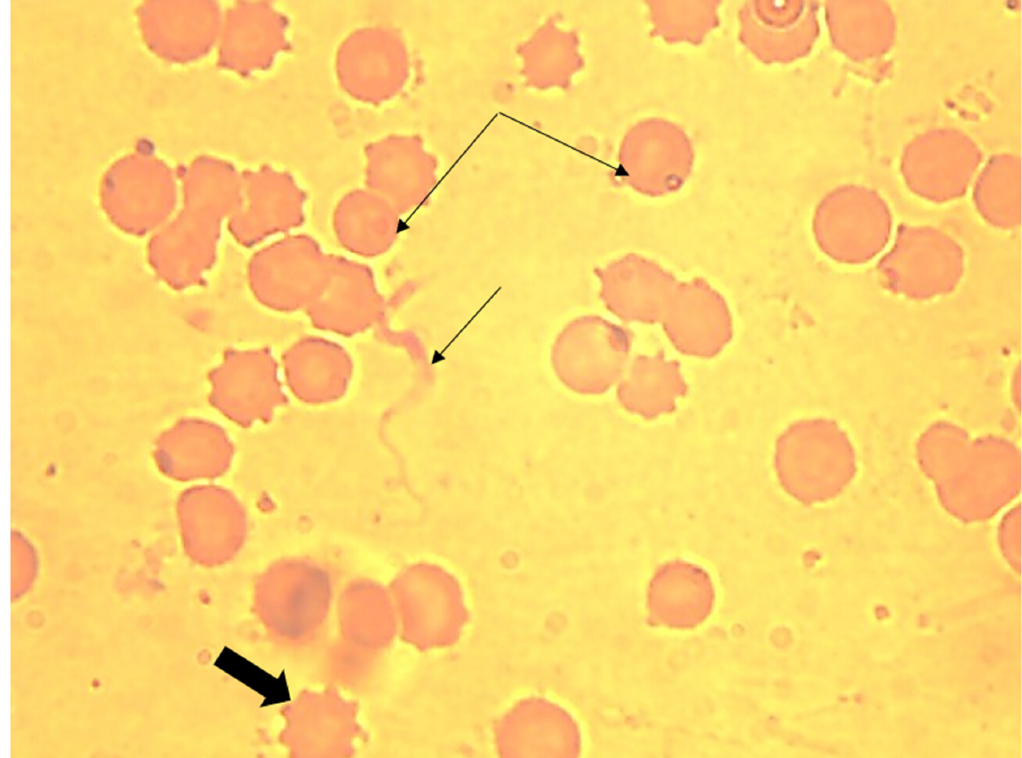
Figure 1. The blood picture of Trypanosoma species (arrow) infected horses showing the echinocyte (block arrow) and red blood cells of different sizes (double arrow) X1000 magnification